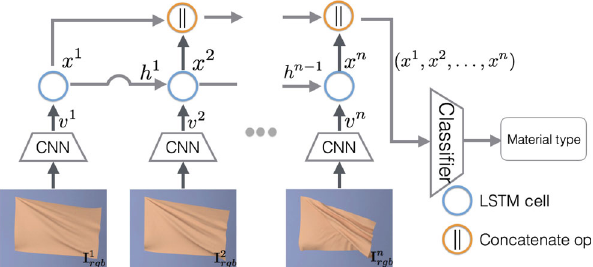
Fig. 3 Network model from Ref. [20]. The material is modeled by learning motion patterns of image features given by CNNs. Reproduced with permission from Ref. [20], c (cid:2) The Author(s)